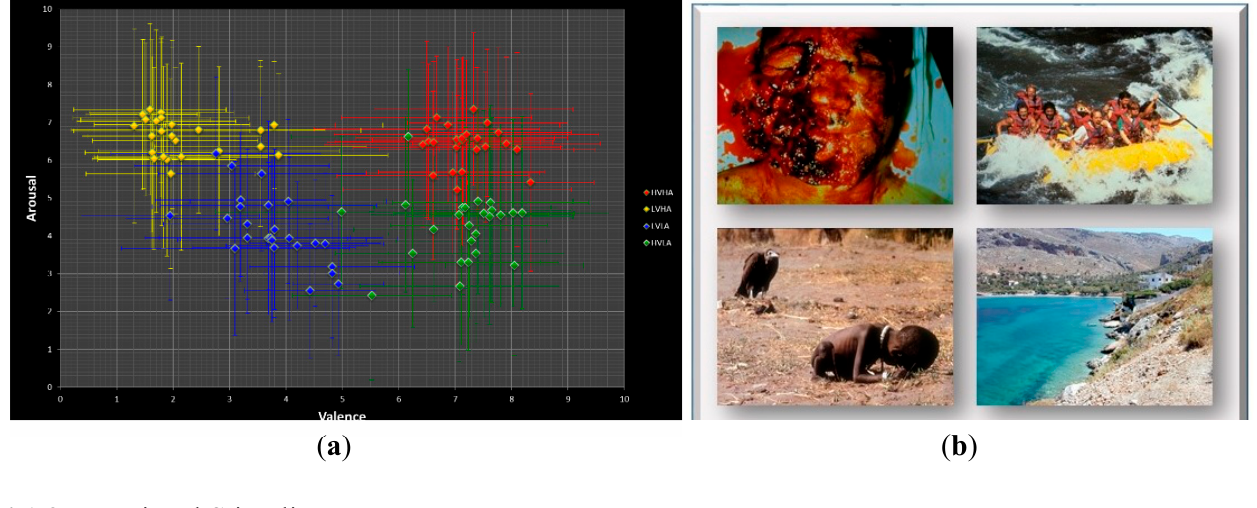
Figure. 3. ( a ) Distribution of the selected 100 IAPS pictures in the valence-arousal plane, where each dot contains information of both the average score and the estimated standard deviations along the two axes and ( b ) examples of the selected pictures, where the upper-right, upper-left, bottom-left, and bottom-right pictures are HVHA, LVHA, LVLA, and HVLA stimuli,